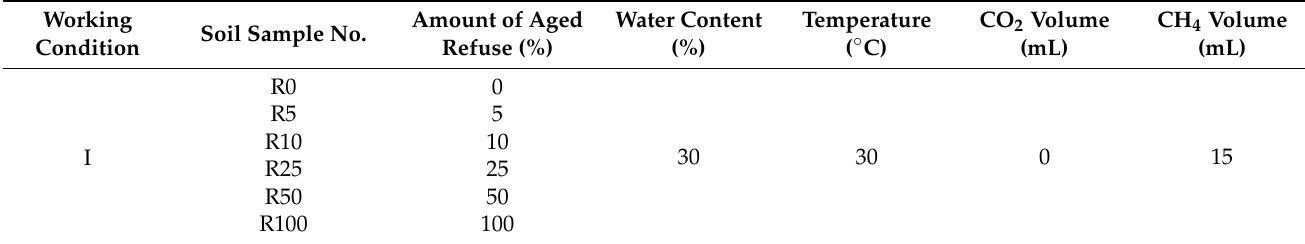
Table 3. Incubation scheme of cover soil modified with aged